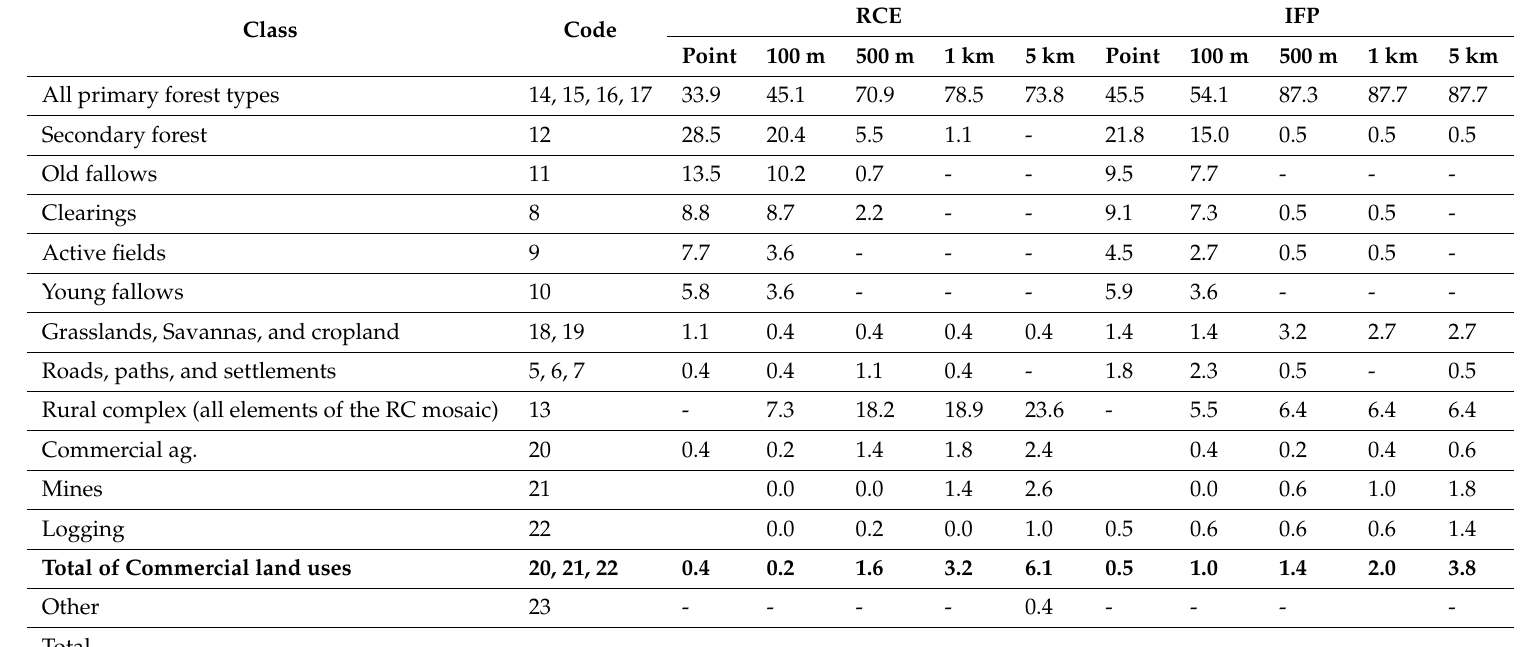
Table 3. Percent land cover estimates for the sample points, compared to dominant land cover within the concentric circular bu ff er areas around